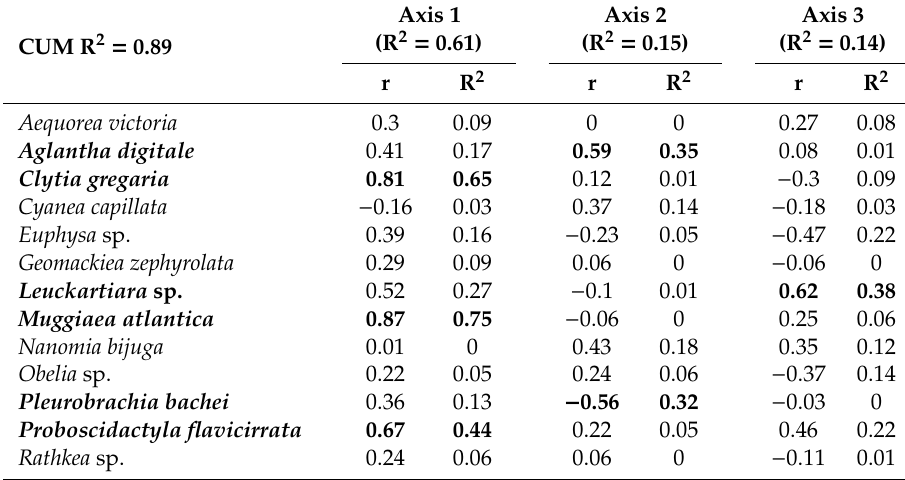
Table 2. Pearson correlation coe ffi cients (r) and correlations (R 2 ) between jellyfish and the NMS ordination axes. Taxa strongly correlated with each axis (R 2 > 0.3) are in bold. Total cumulative R 2 of the ordination is given as CUM R 2 .